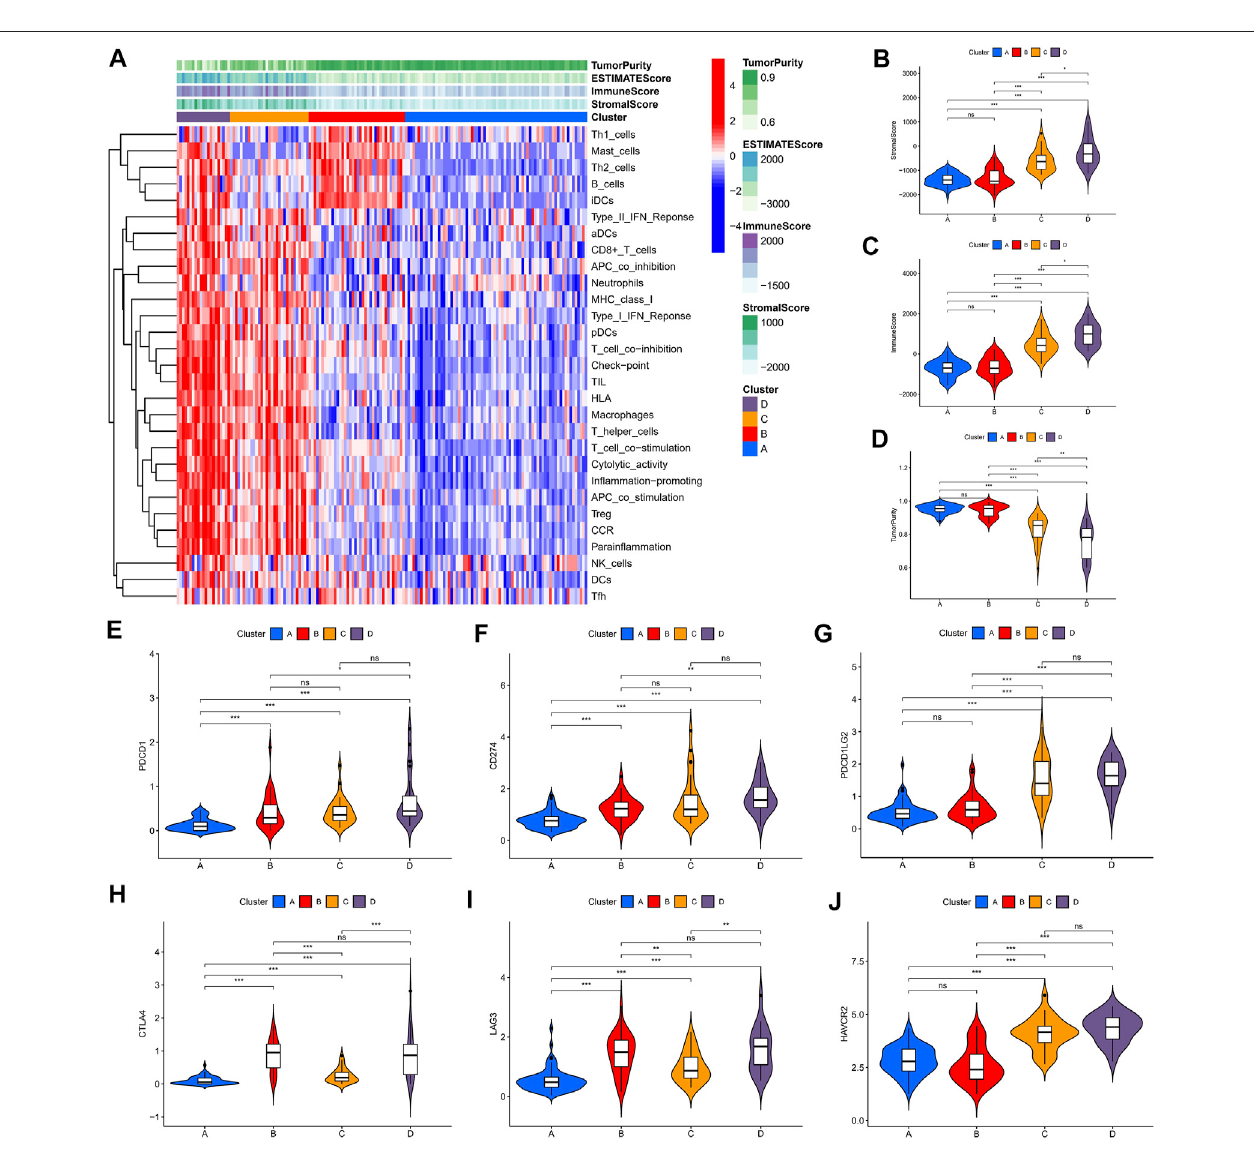
FIGURE 4 | Immune characteristics of the four clusters in the CGGA-2 dataset. (A) Heat map of the four immune clusters based on ssGSEA scores. (B) Stromal scores, (C) immune scores, and (D) tumor purity of different clusters. (E – J) Violin plots for the immune checkpoint gene expressions of PDCD1, CD274, PDCD1LG2, CTLA-4, LAG3, and HAVCR2 in different